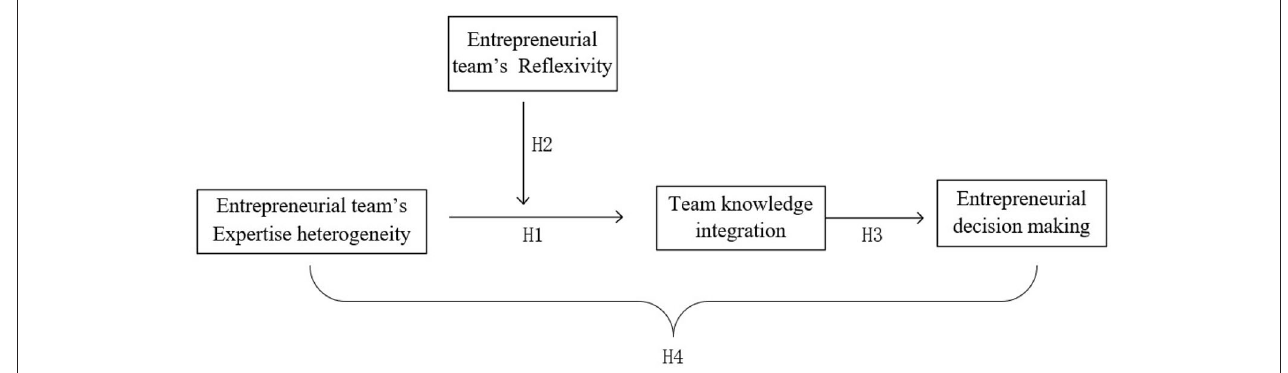
FIGURE 1 | The hypothesized